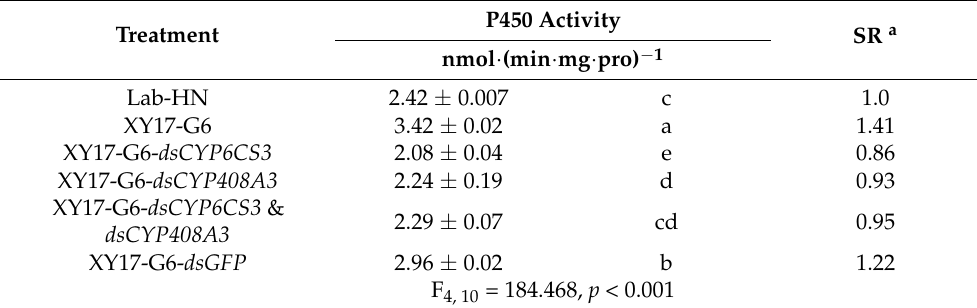
Table 1. P450 activity of the Lab-HN strain and XY17 population 48 h after RNAi.